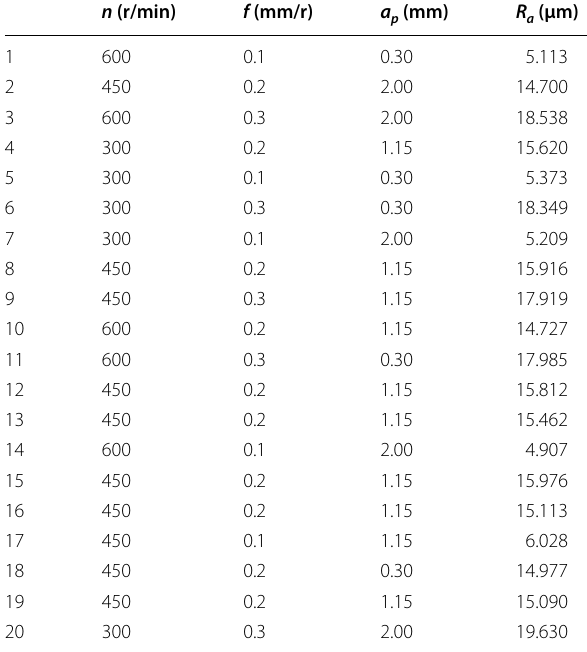
Table 2 Design of regression analysis experiment